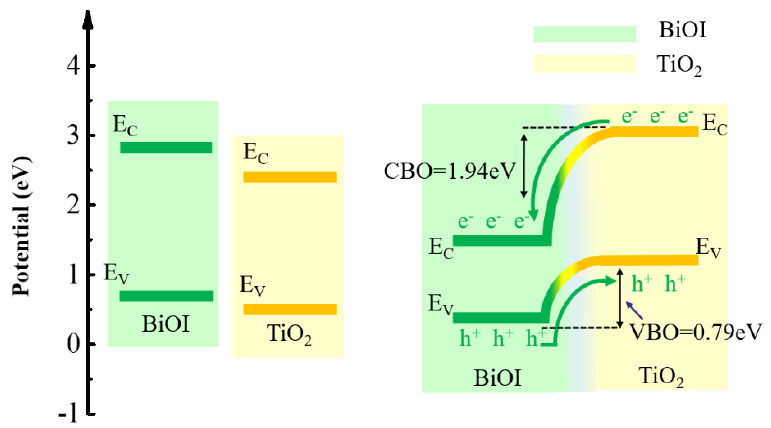
Figure 8. Schematic diagram of the 1I–BiOI / TiO 2 heterojunction and its energy band distribution.